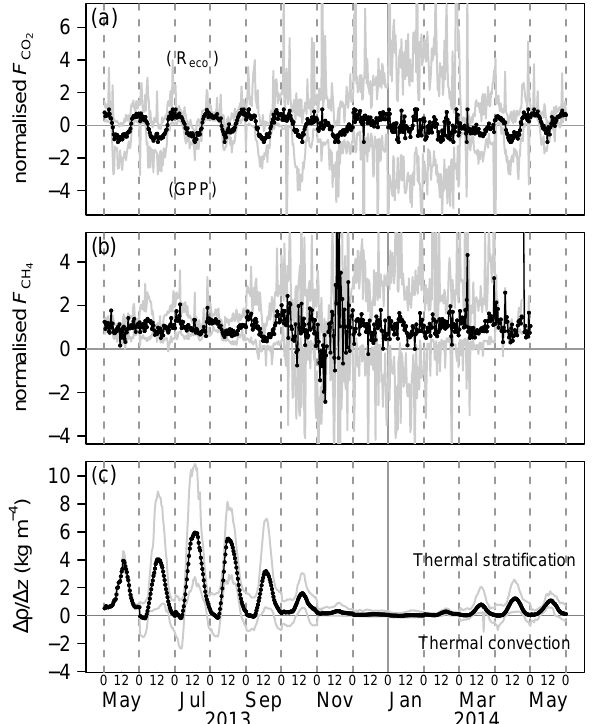
Figure 3. Average diurnal cycle of (a) CO 2 flux, (b) CH 4 flux and (c) the water density gradient per month. The numbers at the x axis denote midnight (00:00) and midday (12:00) in UTC. Midnight is also illustrated with a dashed line. Black and grey lines represent the mean and the range respectively. The CO 2 and CH 4 fluxes are nor- malised with the monthly minimum/maximum and the median of the half-hourly fluxes respectively. Although the zero line is slightly shifted due to normalisation, positive CO 2 fluxes roughly indicate the dominance of R eco against GPP, negative fluxes the dominance of GPP against R eco . The period of ice cover was excluded from the calculation of the temperature gradient. A density gradient equal to or below 0 indicates thermally induced convective mixing down to the bottom of the open water body of the shallow lake; positive gra- dients indicate thermal stratification.